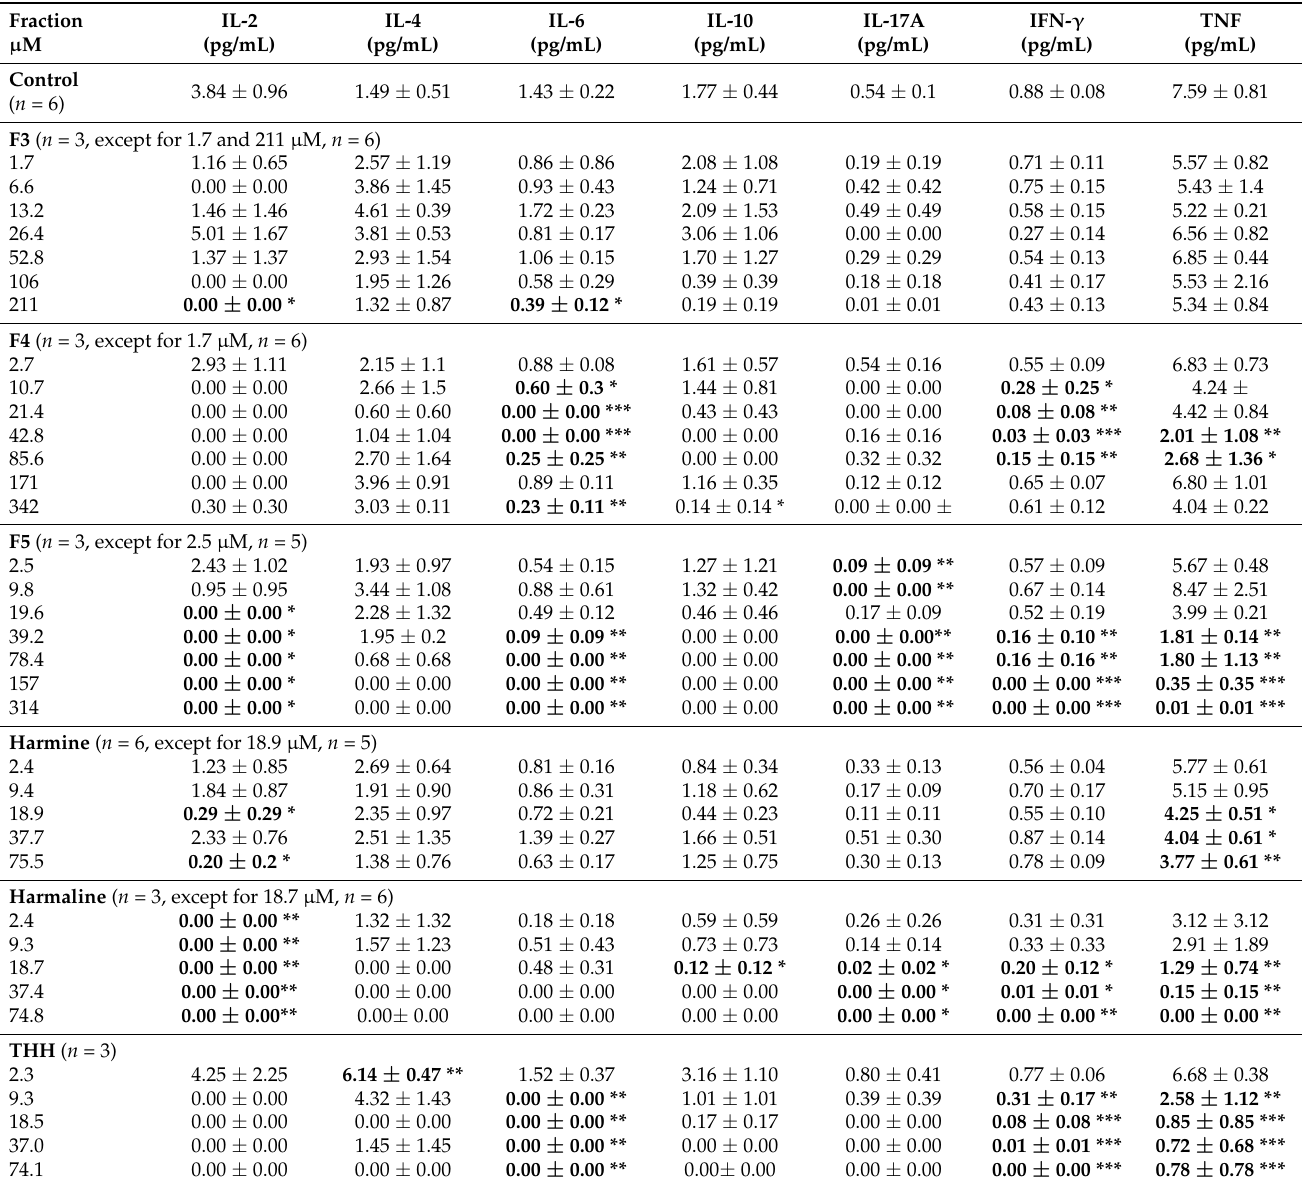
Table 1. Cytokine production by BV-2 cells after treatment for 2 h with Banisteriopsis caapi extract fractions F3, F4, and F5 and the β -carbolines harmine, harmaline, and tetrahydroharmine (THH). Values significantly different from controls are shown in